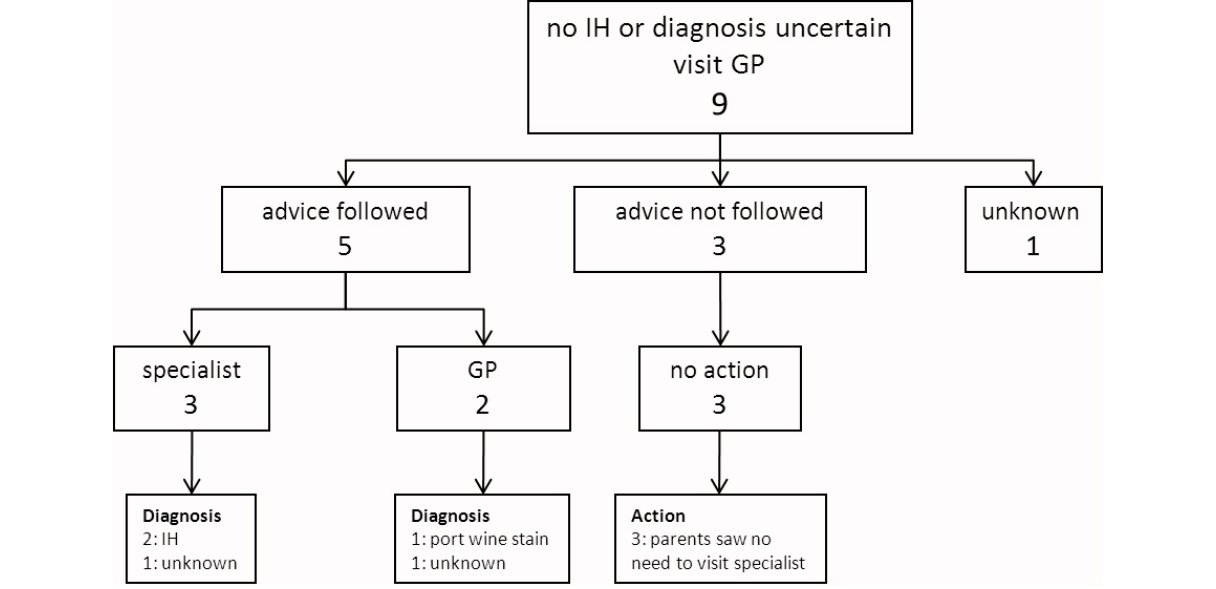
Figure 4. Flowchart of the compliance of the parents of a child with no Infantile hemangioma (IH) or where it was not possible to make an accurate diagnosis by the dermatologist via e-consultation. The flowchart shows which doctor the parents visited and to what actions (eg, diagnostic evaluation and/or treatment) it has led. The figures indicate the number of patients. General practitioner (GP).